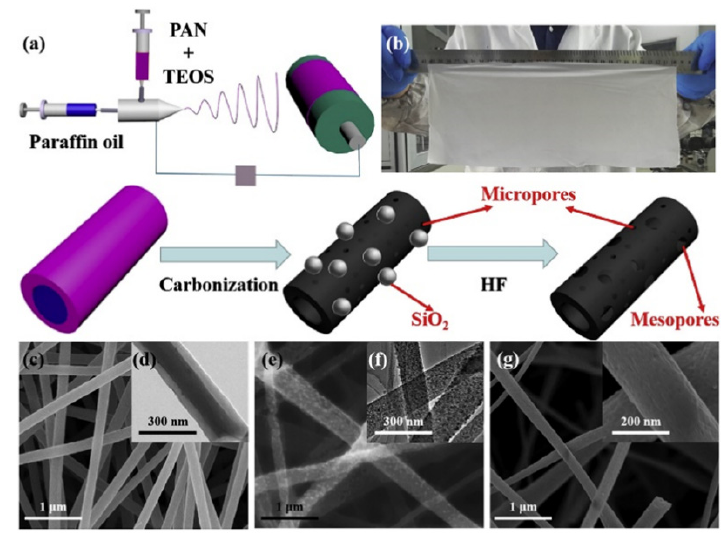
Figure 4. Example of carbon nanofiber (CNF) membrane fabrication using a polyacrylonitrile (PAN) precursor by electrospinning and carbonization, with sacrificial SiO 2 doping to achieve controlled mesoporosity; ( a ) schematic illustration of the synthesis of PCCNF. ( b ) digital photo of paraffin oil@PAN/TEOS. ( c ) SEM image and ( d ) TEM image of paraffin oil@PAN/TEOS. ( e ) SEM image and ( f ) TEM image of hollow carbon/SiO 2 . ( g ) SEM image of PCCNF [87].